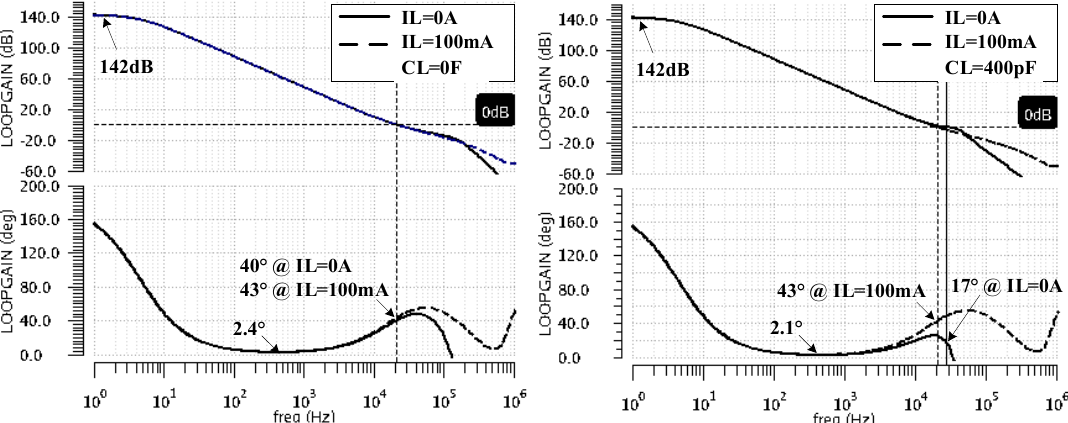
Figure 6. The frequency characteristics of the LDO loop gain, (cid:1846) (cid:3013)(cid:3005)(cid:3016) , for CL = 0 F ( left ) and 400 pF ( right ) and extreme IL values: 0 mA and 100